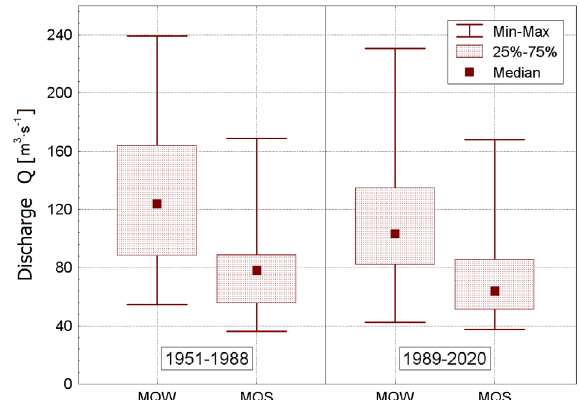
Fig. 14. Range of variability of the seasonal discharge of the Warta River in Poznań in sub-periods 1951– 1988 and 1989–2020. MQW, average discharge in the cold half-year (November–April; unit: m 3 · s −1 ); MQS, average discharge in the warm half-year (May– october; unit: m 3 · s −1